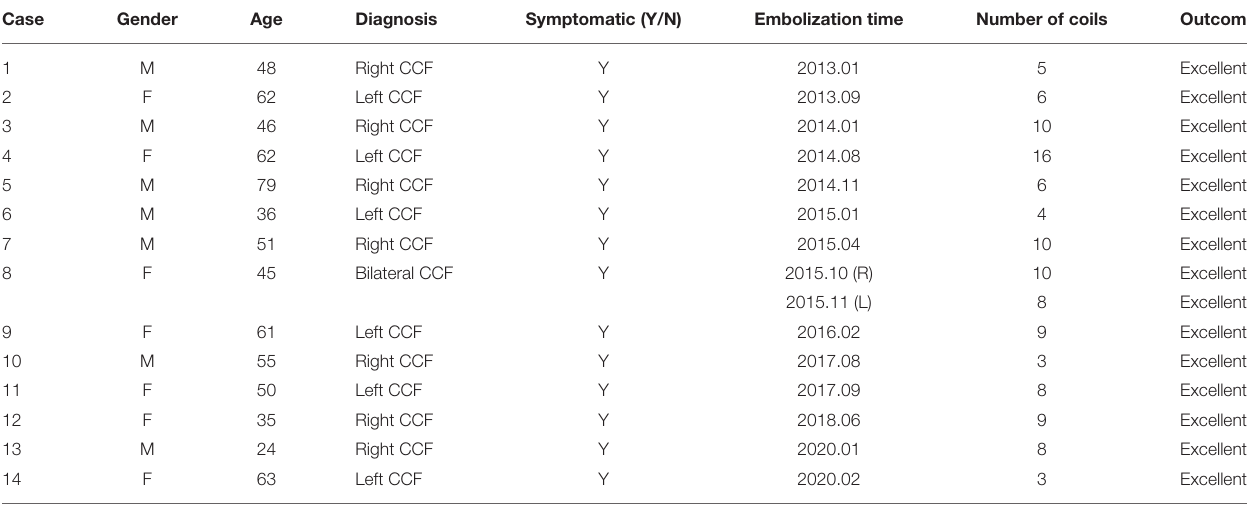
TABLE 1 | Summary of patients with direct CCFs who underwent point-to-point coil embolization of the fistula. Case Gender Age Diagnosis Symptomatic (Y/N) Embolization time Number of coils Outcomes